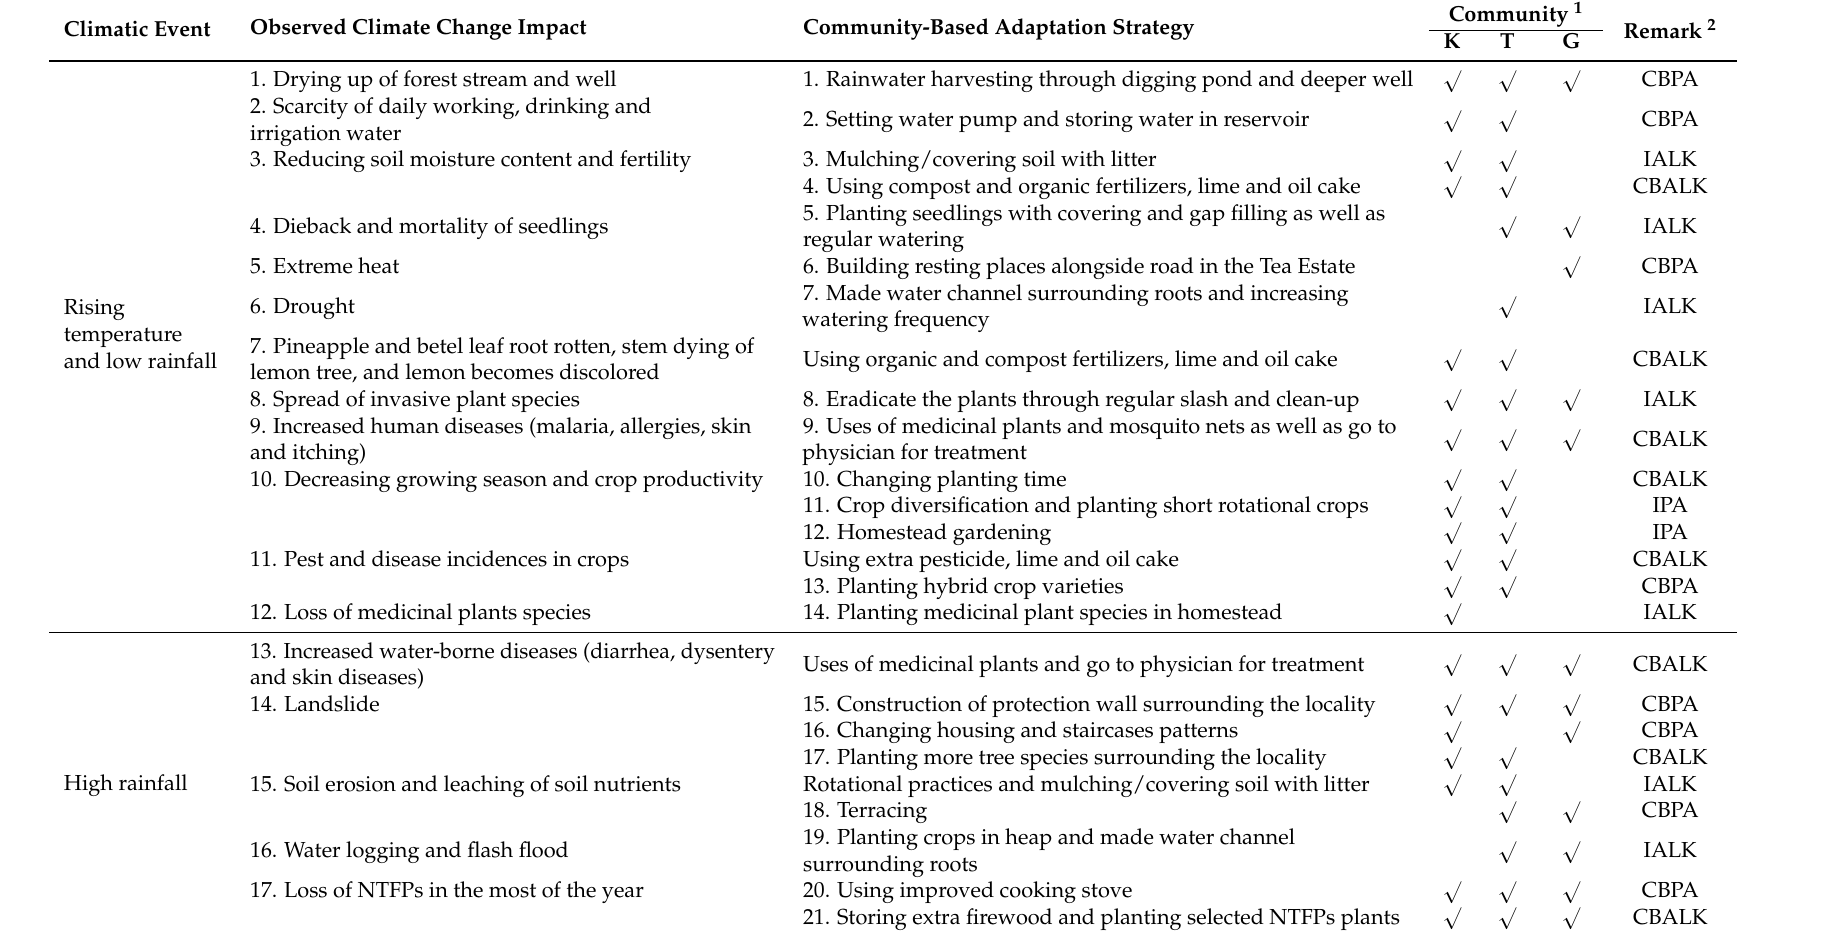
Table 4. Observed climate change impacts and community-based adaptation strategies followed by the three indigenouscommunities in